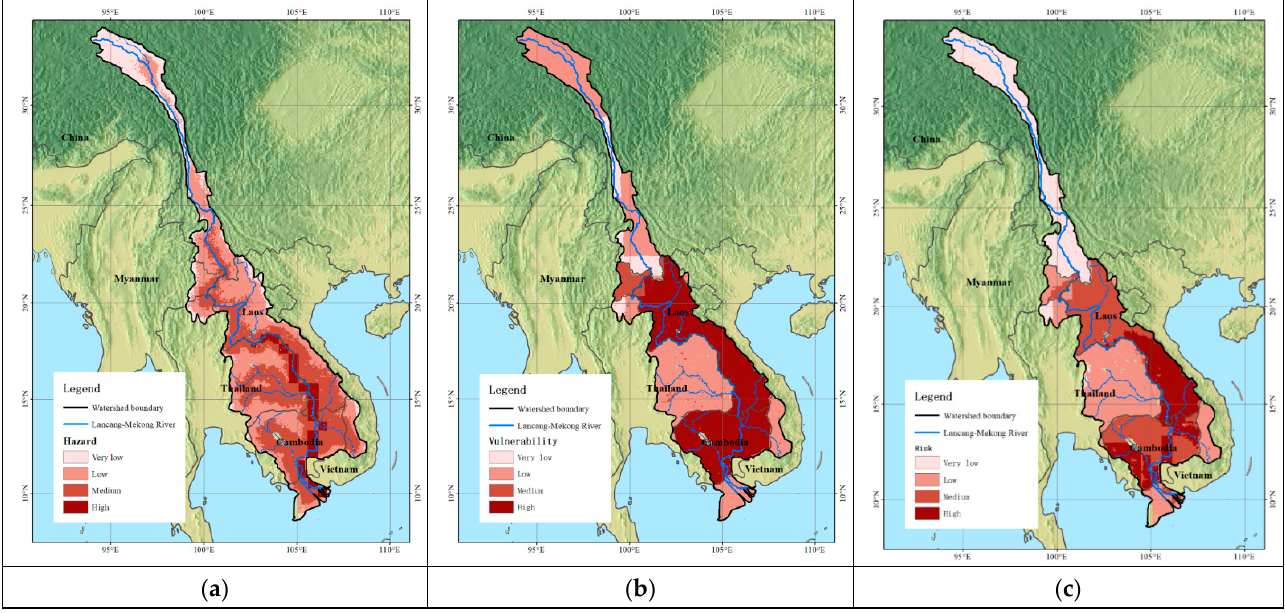
Figure 3. Assessment result at the watershed scale. ( a ) Hazard assessment result; ( b ) Vulnerability assessment result; ( c ) Risk assessment result. assessment result; ( c ) Risk assessment